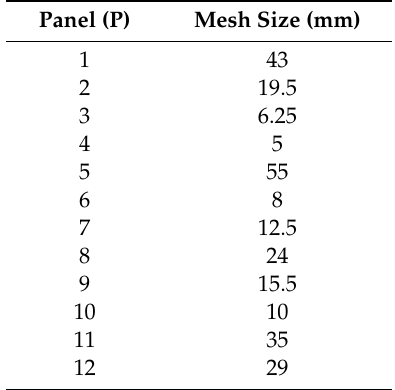
Table 1. Sequence and mesh size (mm) of gillnets panels.